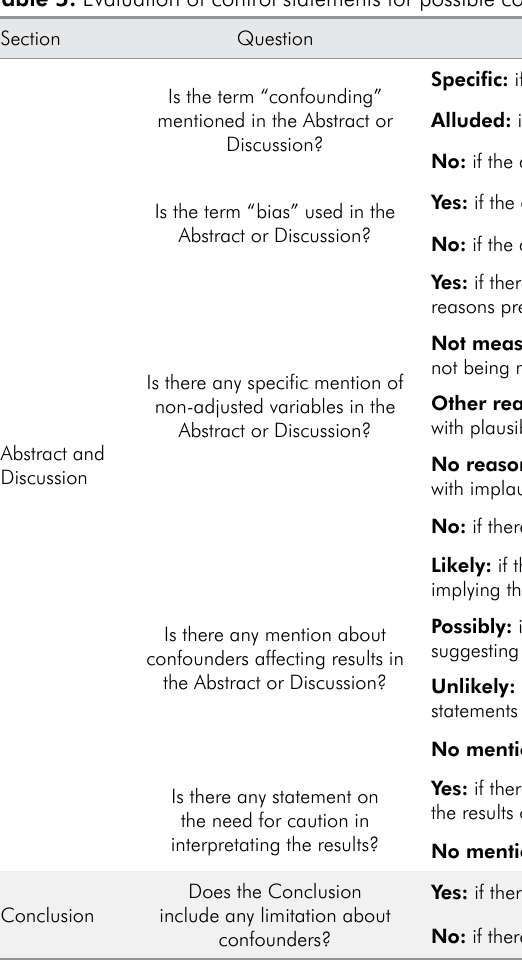
Table 5. Evaluation of control statements for possible confounders and bias consideration